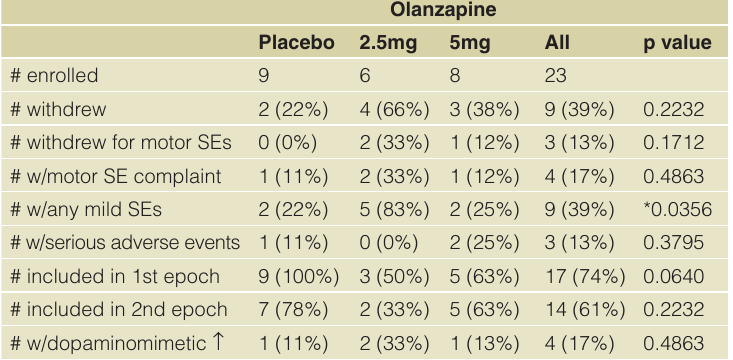
Table 3. Subject retention and side effects by